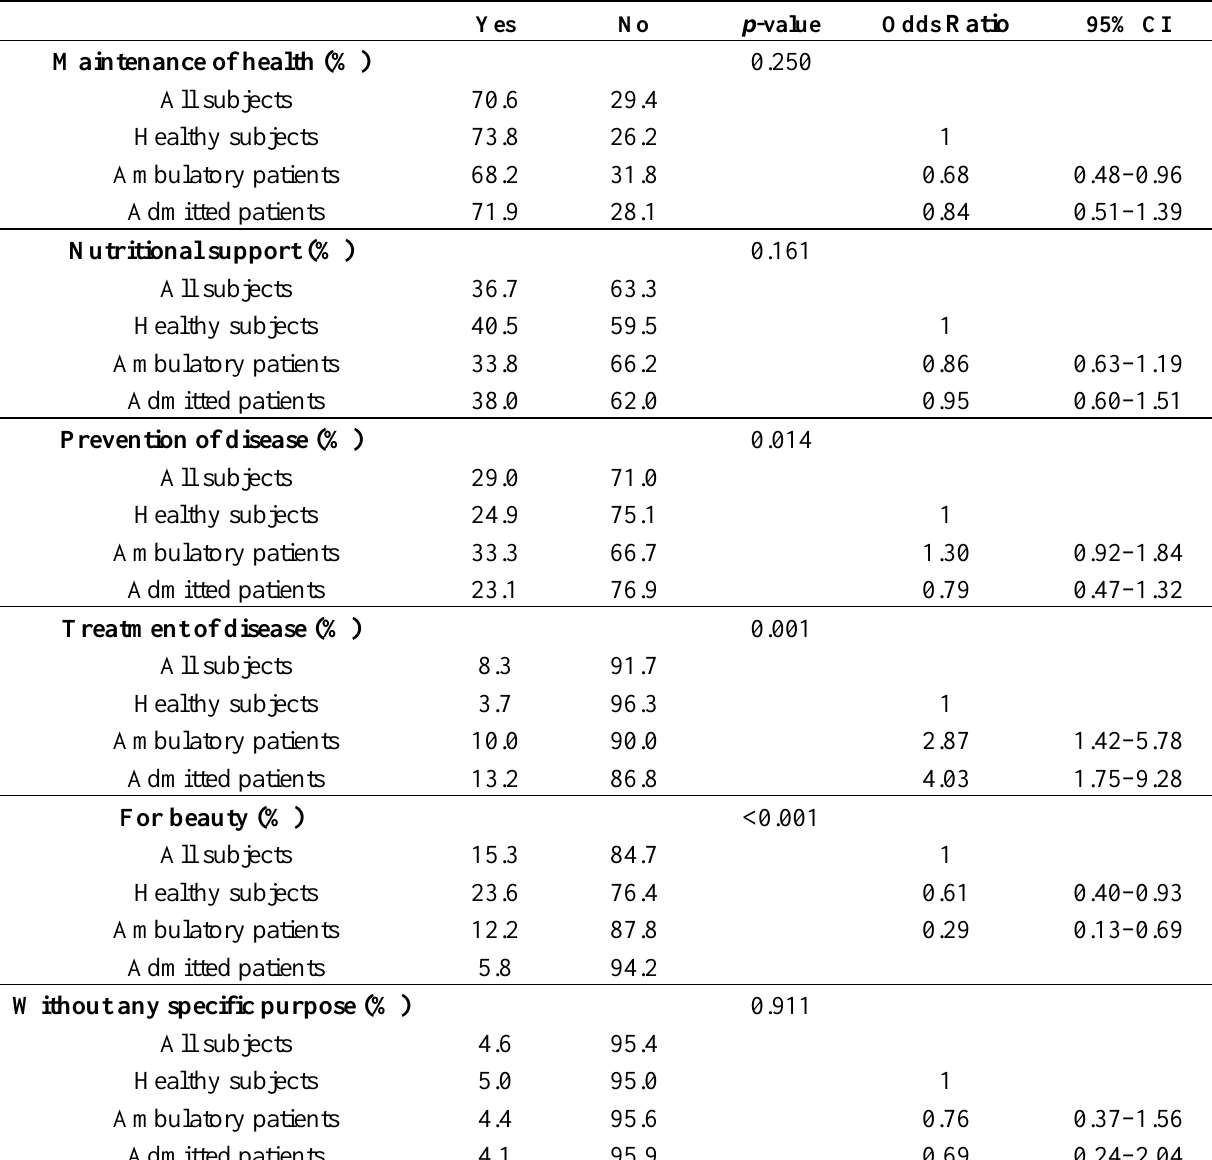
Table 3. Purpose of using dietary